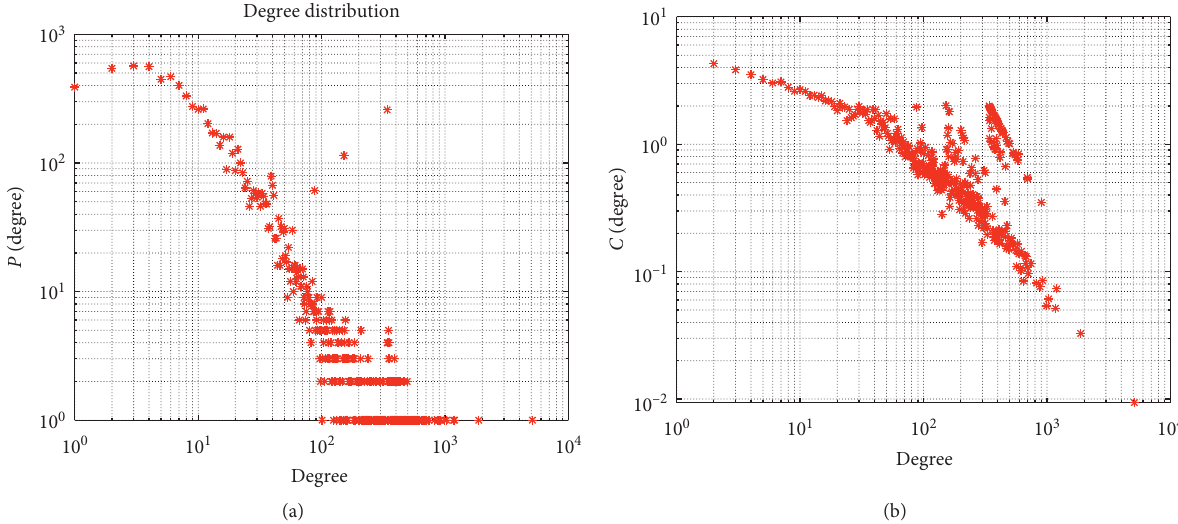
Figure 2: Result of cumulative degree distribution and hierarchical organization. (a) Cumulative degree distribution. (b) Hierarchical organization.